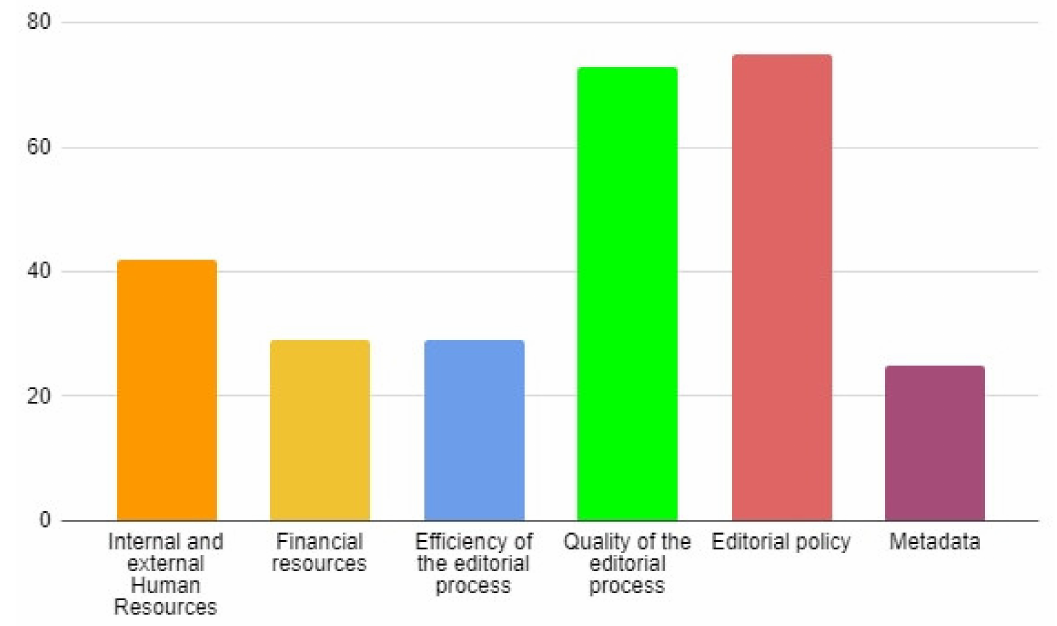
Figure 2. Levels of compliance with or implementation of the